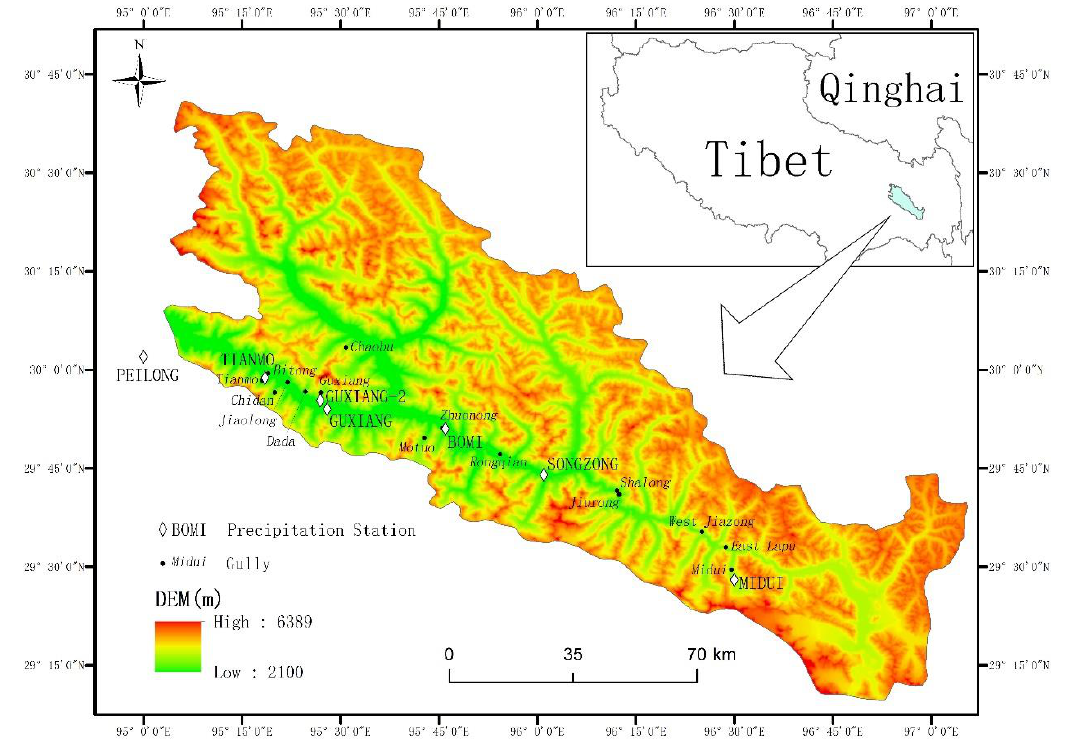
Figure 1. Debris flow gullies and precipitation stations in the Ranwu–Peilong section of the Parlung Zangbo Basin. Table 1. Debris flow events recorded in the study area from 2012 to 2020.